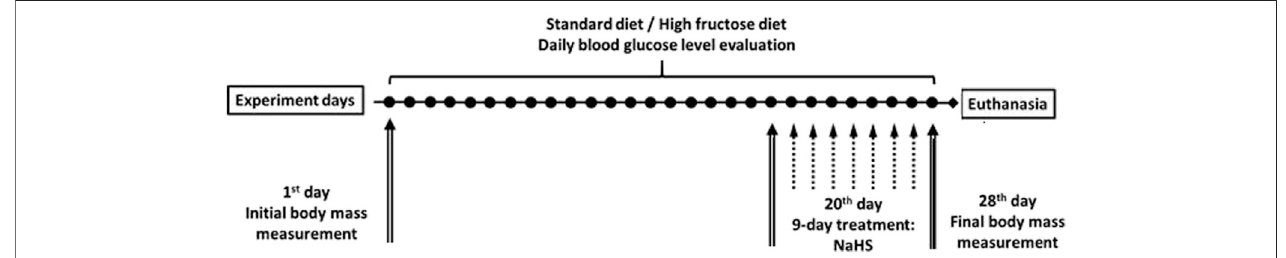
FIGURE 1 | Overview of the